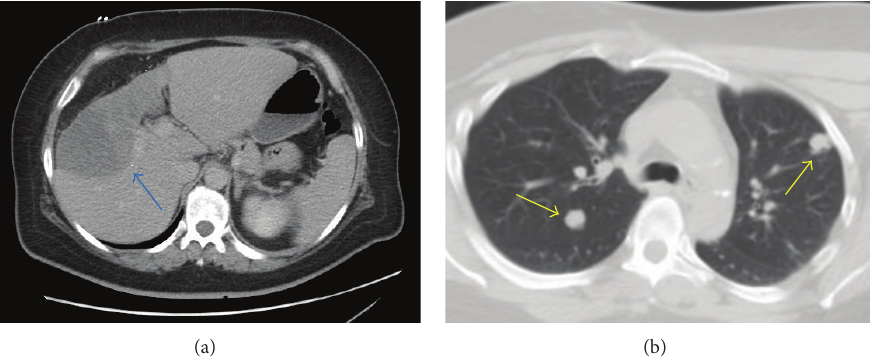
Figure 1: (a) Computed tomography (CT) of the abdomen showing a large hepatic mass, measuring 12cm × 5.5 cm and designated by the blue arrow. (b) CT of the chest showing metastatic nodules, designated by yellow